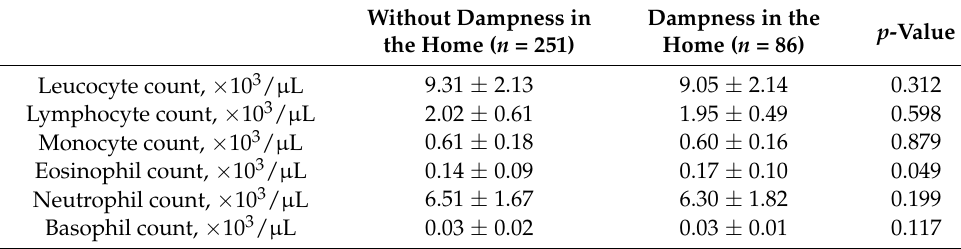
Table 3. Relationship between white-blood-cell count and indoor-dampness exposure.